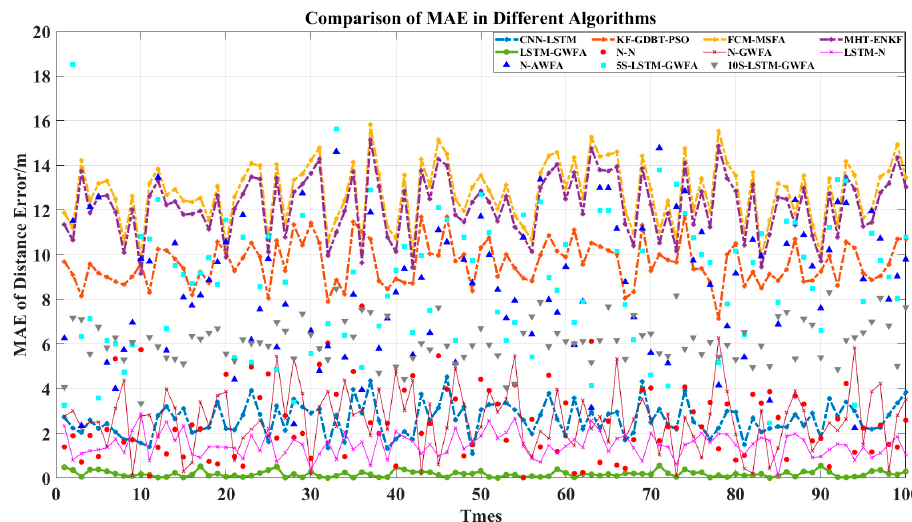
Figure 4. Comparison of MAE with 100 tracks in different algorithms.